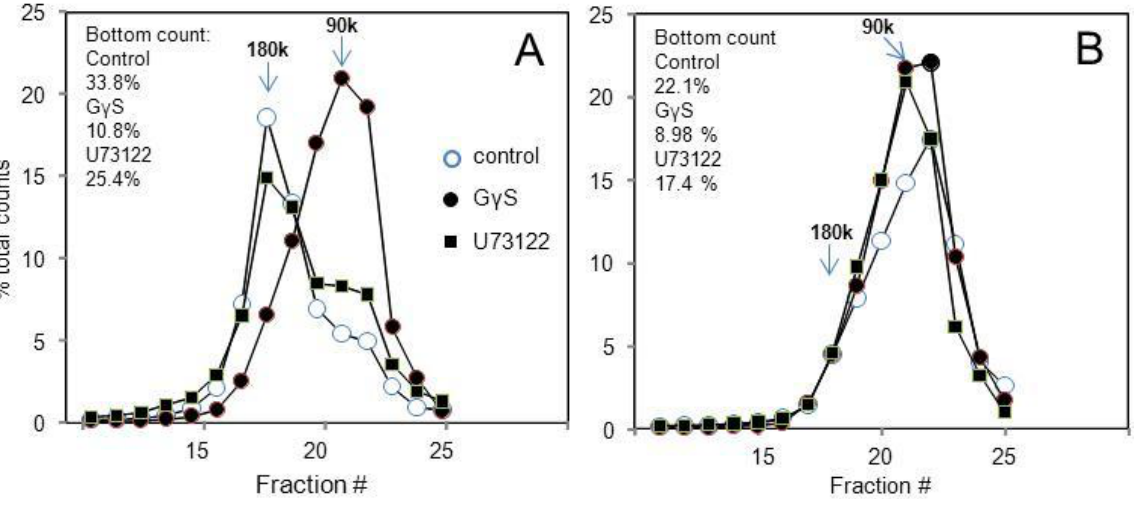
Figure 5. Y2 receptor aggregates in particulates from rabbit tissues yield mainly Gi-Y2 monomer in response to G γ S but largely the heteropentamer upon treatment by U73122. Particulates from rabbit kidney ( A ) and anterior hypothalamus ( B ) were incubated with 20 µM G γ S or 10 µM U73122 for 15 min at 24 °C, sedimented, resuspended, labeled with 50 pM [ 125 I ]hPYY(3-36) for 15 min at 24 °C, resedimented, lysed at 10 mM each digitonin and cholate and sedimented through a 10%–30% linear sucrose gradient for 6 h at 218,000× g and 5 °C, followed by gradient fractionation and